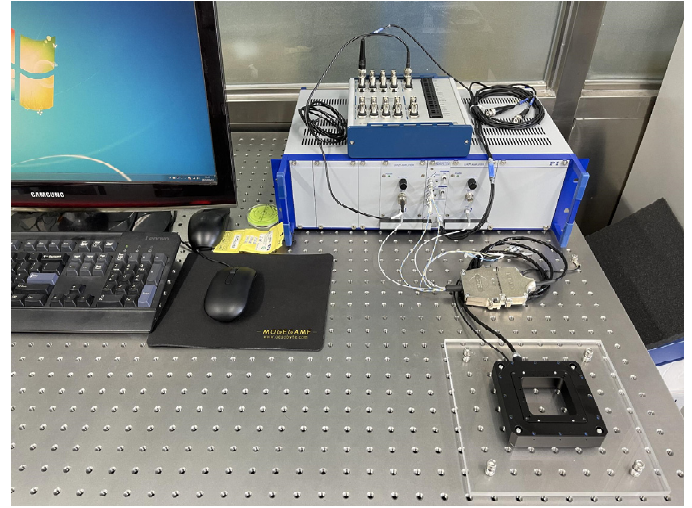
Figure 5. Experimental equipment.